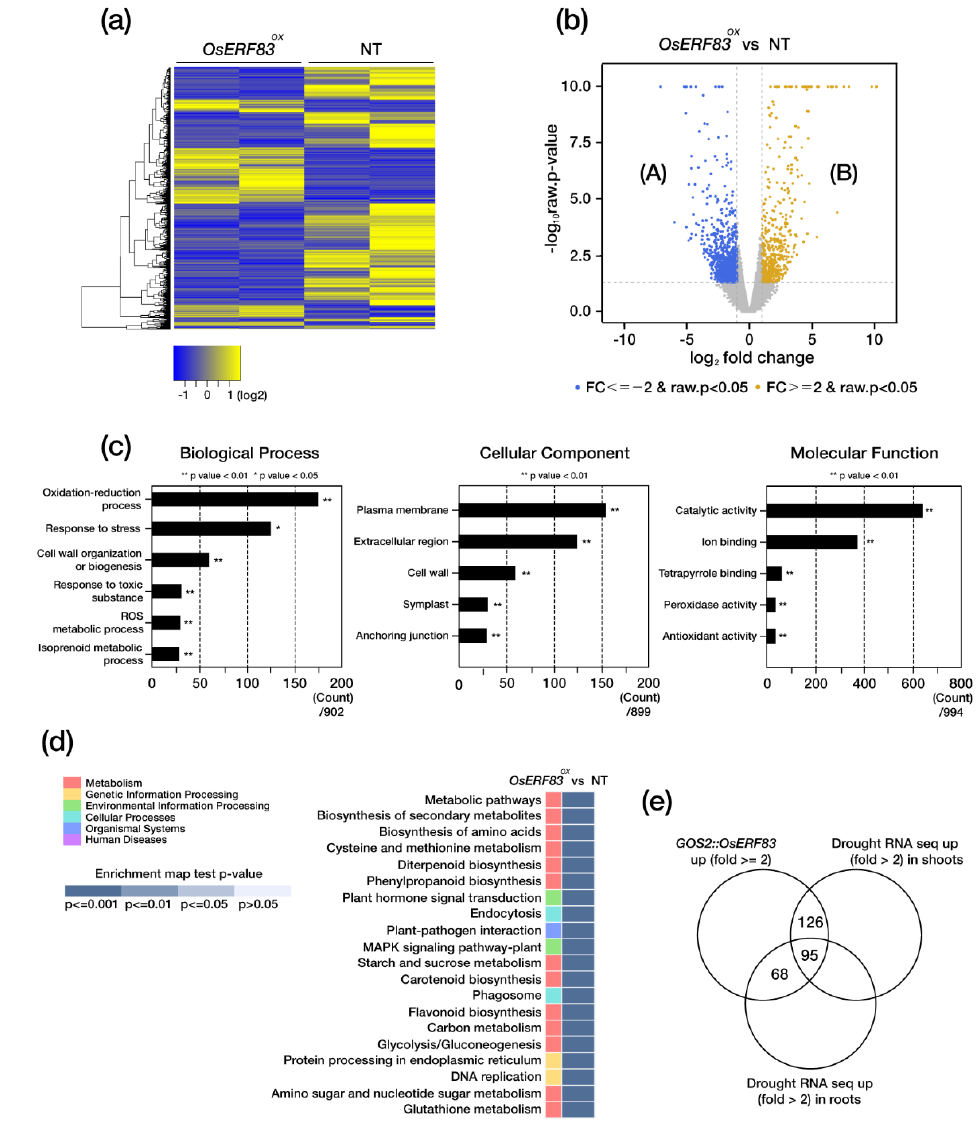
Figure 6. RNA-seq analysis using leaves of OsERF83-MYC OX plants. ( a ) Heat map analysis of differentially expressed genes (DEGs) between OsERF83-MYC OX and NT plants. ( b ) Venn diagram of the numbers of up- and down-regulated DEGs in OsERF83-MYC OX plants compared to NT plants. ( c ) Gene ontology (GO) enrichment analysis of DEGs between OsERF83-MYC OX and NT plants. The most enriched GO term is shown in ‘biological process’, ‘molecular function’, and ‘cellular component’. Asterisks indicate significant enriched GO terms (** p < 0.01, * p < 0.05). ( d ) KEGG pathway enrichment analysis of DEGs. ( e ) Venn diagram of up-regulated genes amongst the DEGs identified in OsERF83-MYC OX and DEGs identified in drought-treated NT shoots and roots from public data (TENOR: http://tenor.dna.affrc.go.jp/, accessed on 30 November 2020).